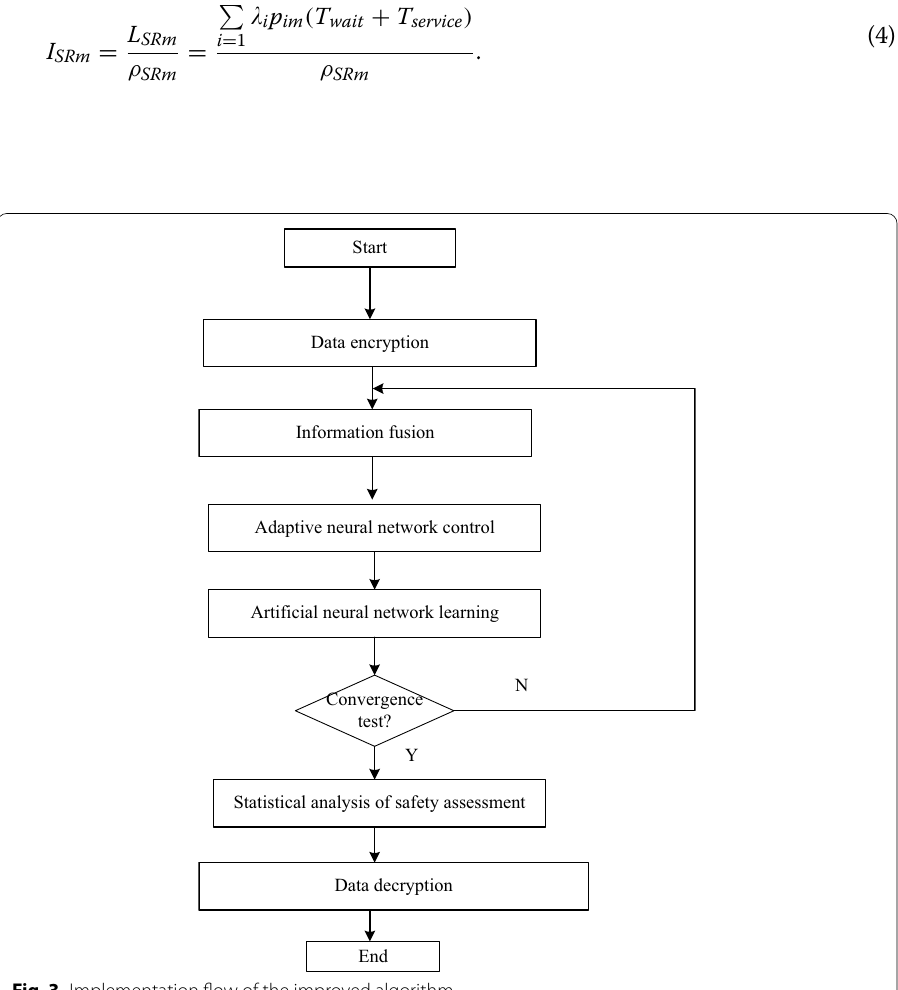
Fig. 3 Implementation flow of the improved